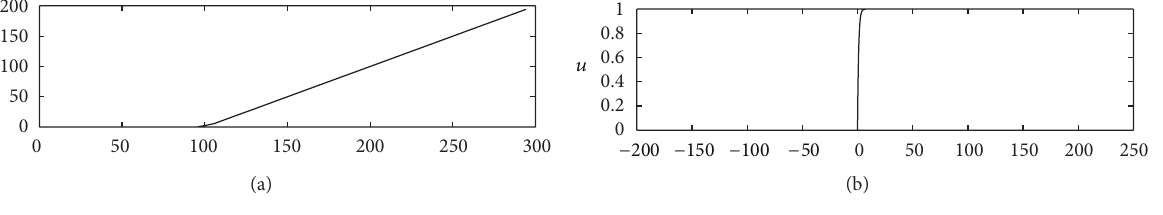
Figure 1: Initial condition of Black-Scholes model.